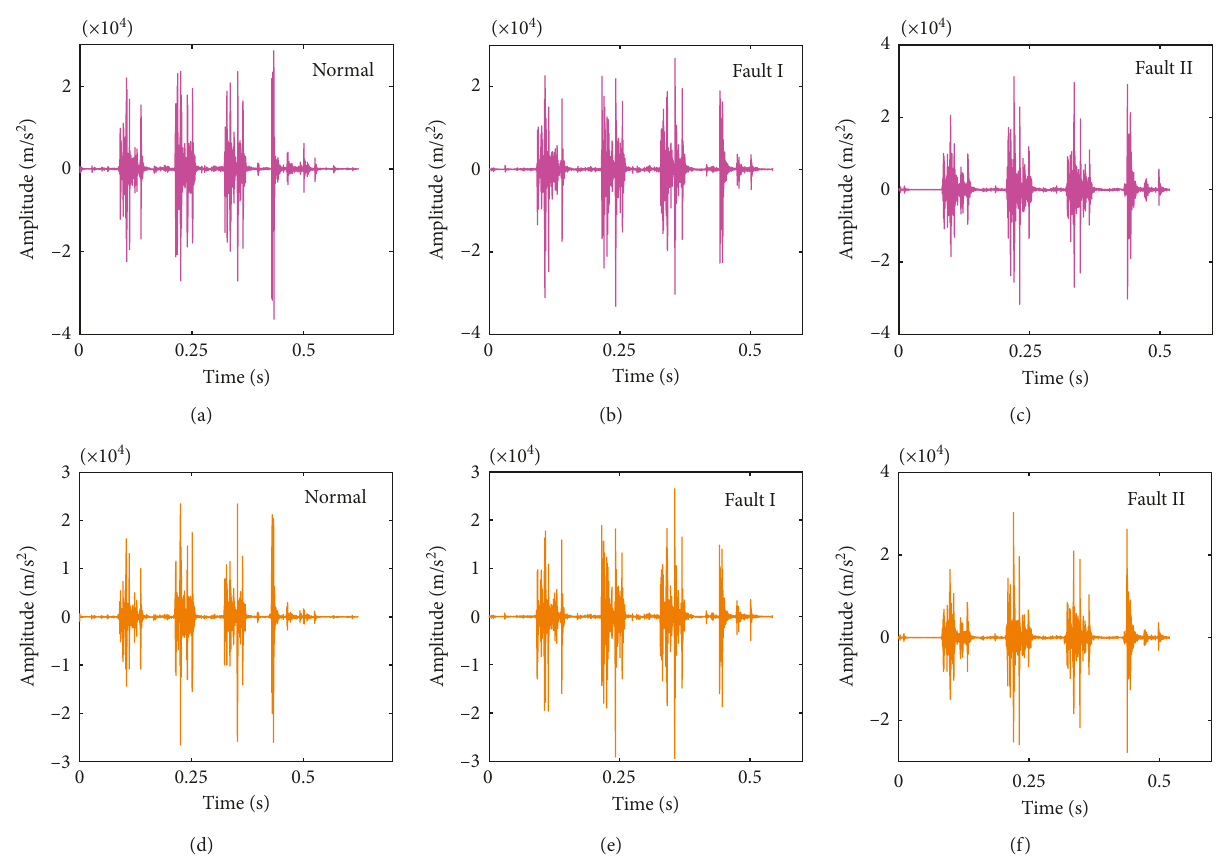
Figure 18: The original signals and the signals filtered by the